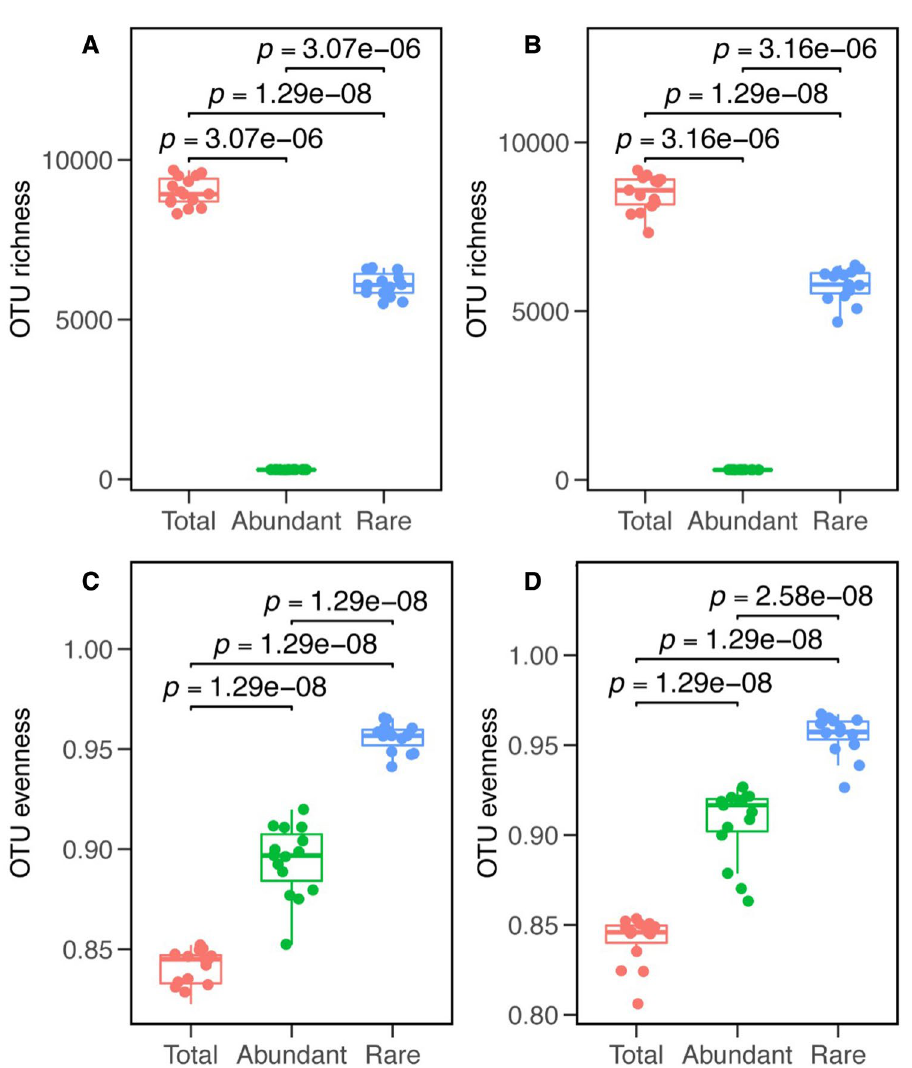
Figure 1. OTU richness ( A ) and Pielou’s evenness ( C ) of the total, abundant, and rare bacterial communities in the soil of tobacco monoculture and variation of OTU richness ( B ) and Pielou’s evenness ( D ) in the soil of tobacco-rice rotation. Box is drawn to represent values from lower 1/4 quartile to upper 1/4 quartile; P < 0.05 represent significant differences among the three taxa according to one-way ANOVA. Total whole bacterial communities; Abundant abundant taxa, Rare rare